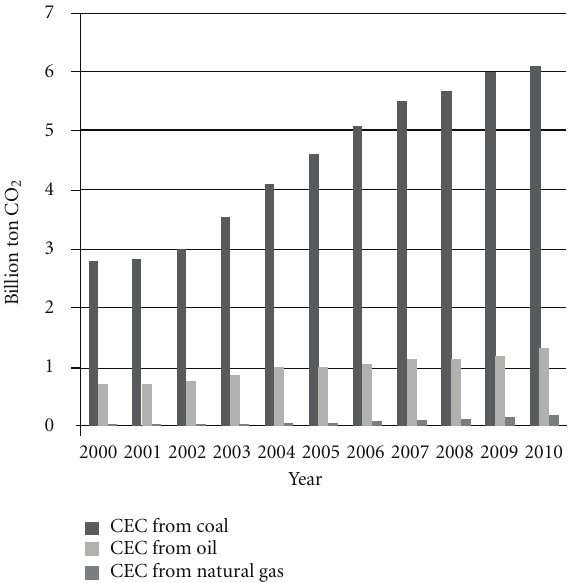
Figure 3: CEC amount from three types of fossil fuels from 2000 to 2010 in